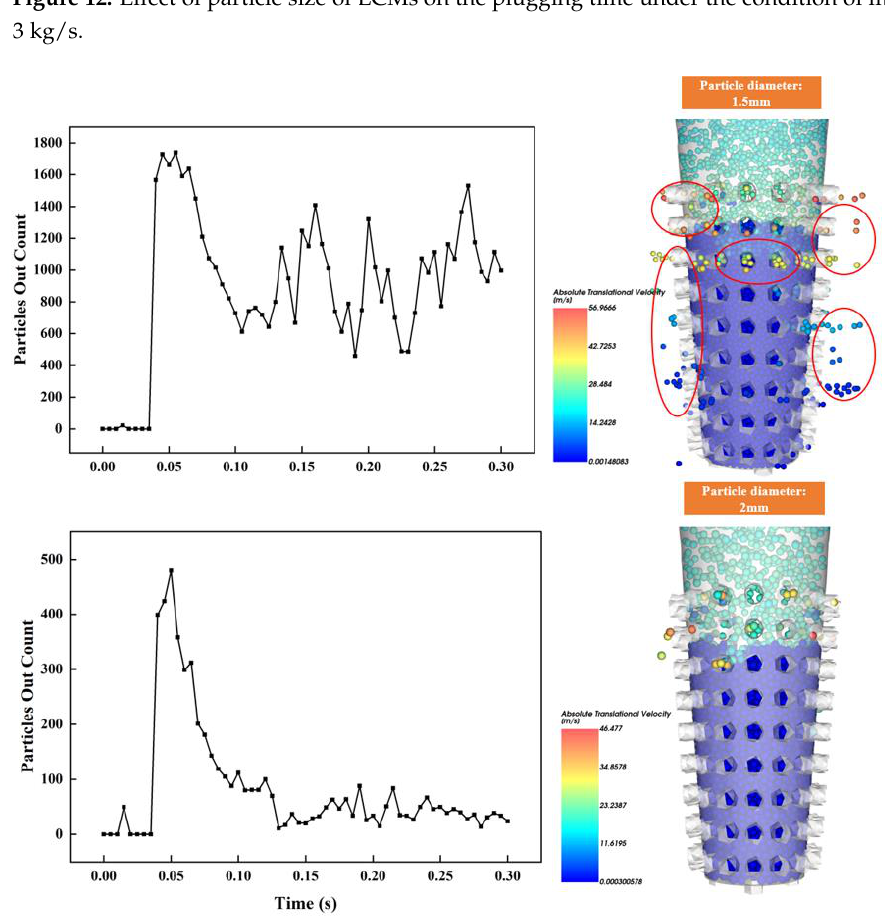
Figure 13. Behavior of LCMs with different particle size to plug the tool.